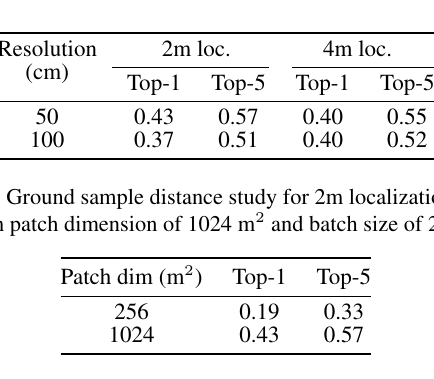
Table 2. Patch dimension study for 2m localization tasks with resolution of 50cm and batch size of